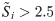
Global measures for patient J.ACC, APL, DoL, Mod and SE for the whole network (scalp + FOE) for patient J. The vertical, dotted lines mark the times when more than four channels reached S˜i>2.5 (see text for explanation). The x-axis marks the time relative to seizure onset (thick vertical solid line). A moving average over ten consecutive windows is displayed with a thick solid black line.